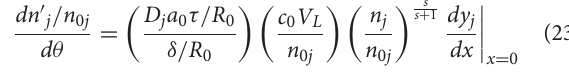
TABLE 2 | Range adopted for each parameter selected for the sensitivity study.